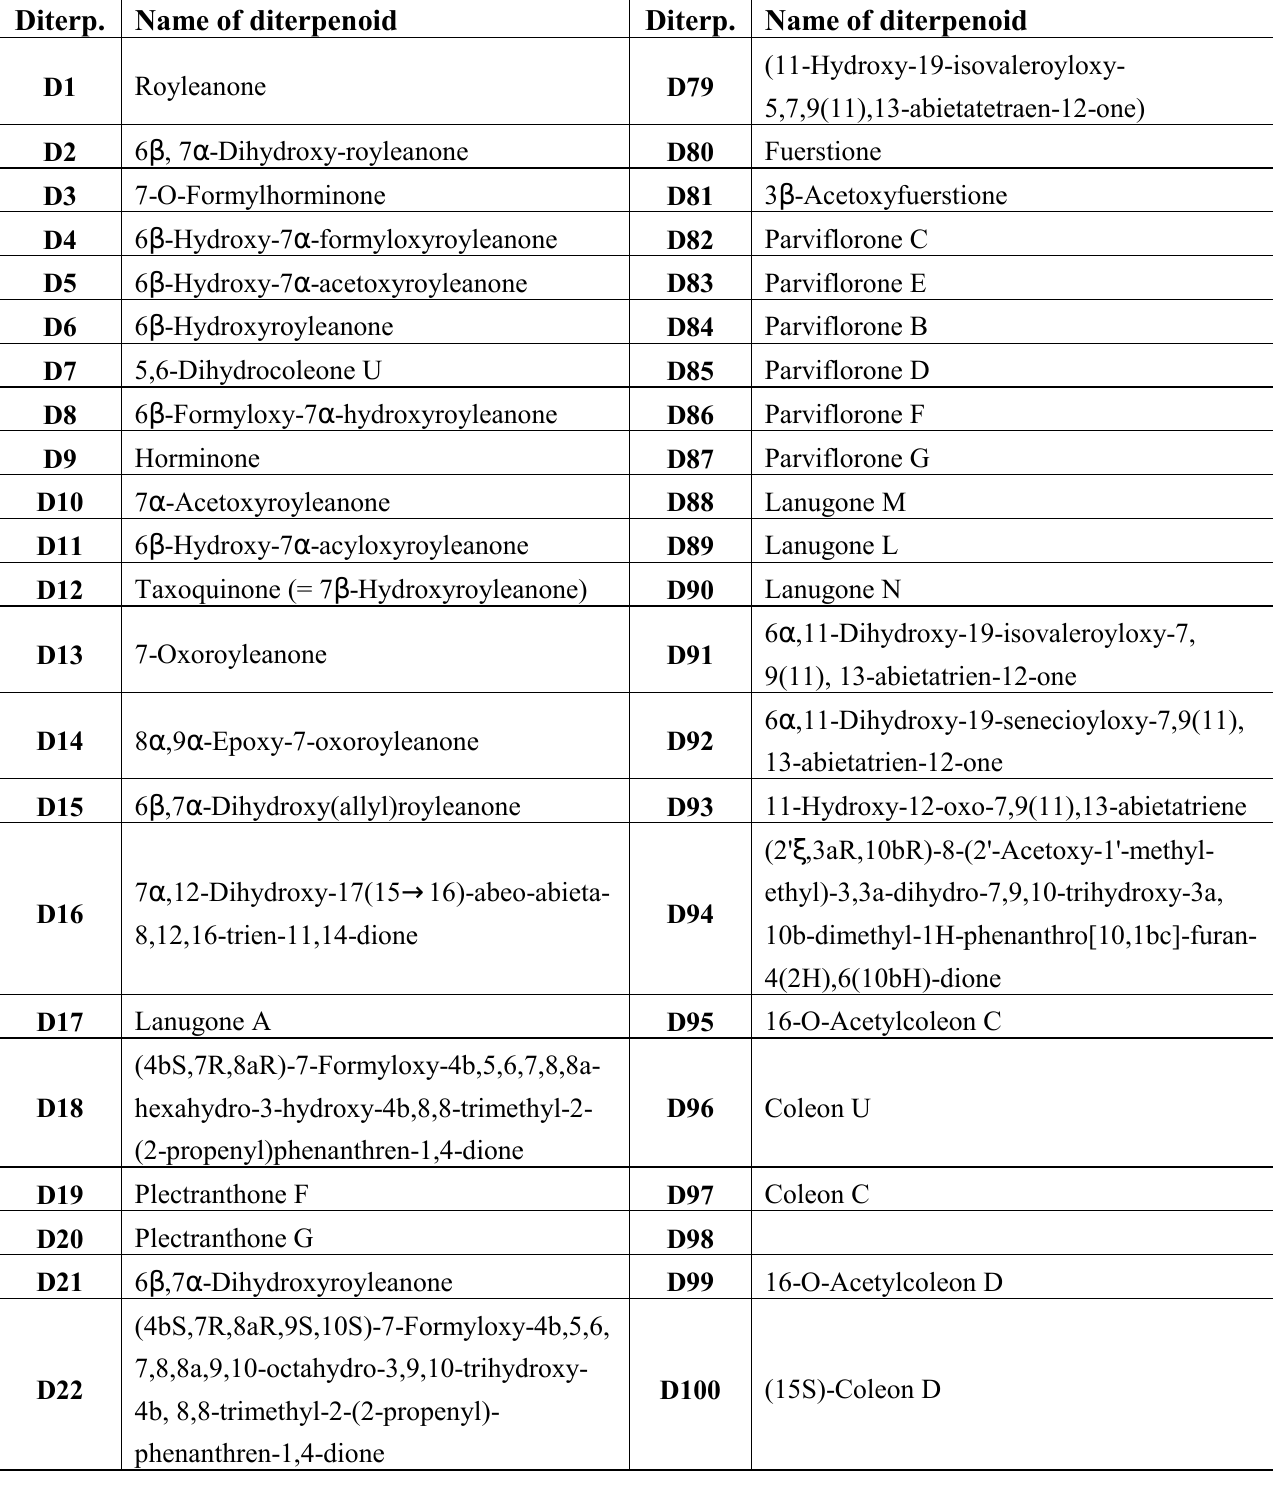
Table 2: Names of diterpenoids encountered in Plectranthus species.